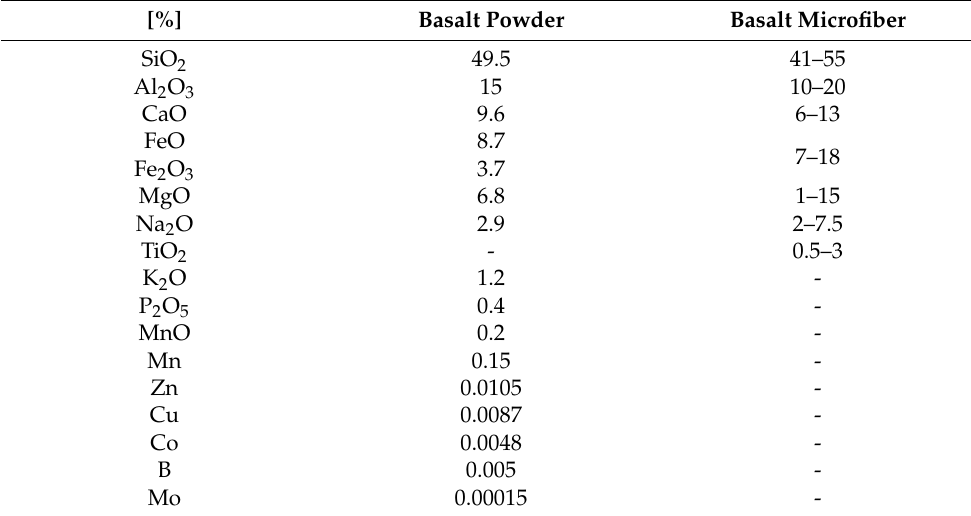
Table 1. The chemical composition of basalt powder and